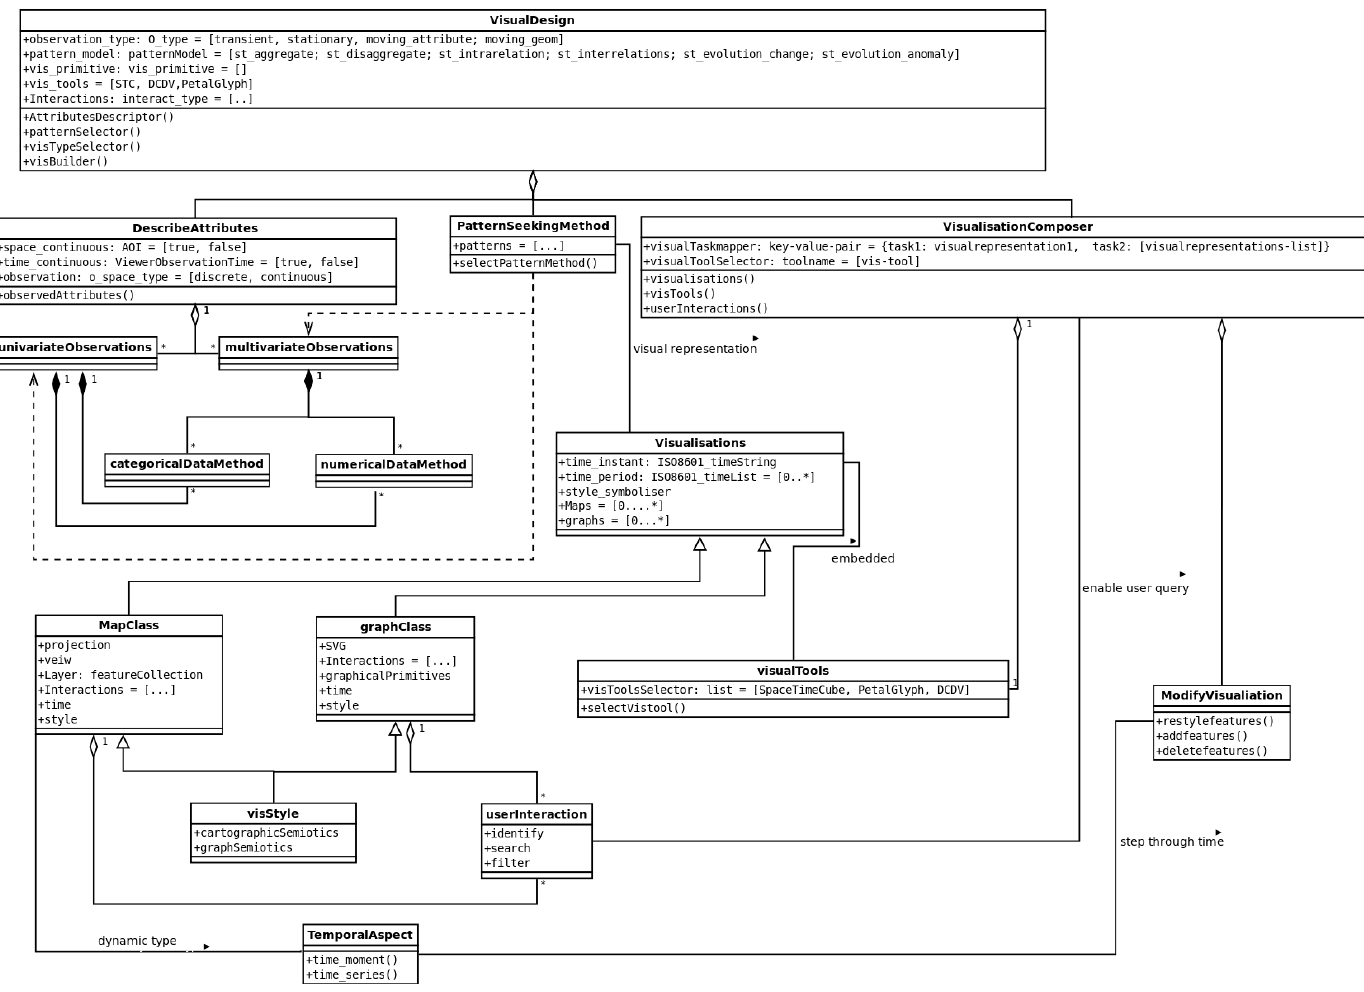
Figure 4. A class diagram showing the main components of the information model.